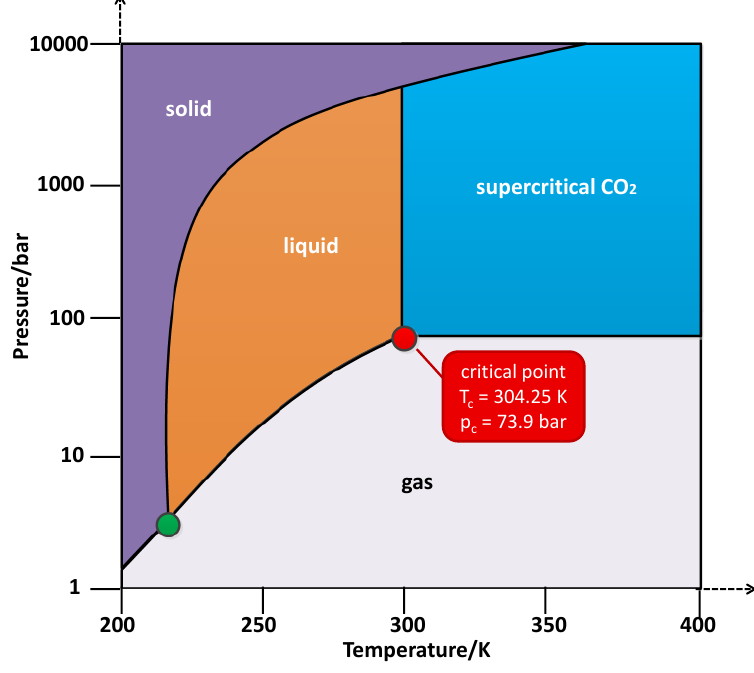
Figure 2. Phase diagram of CO 2 .